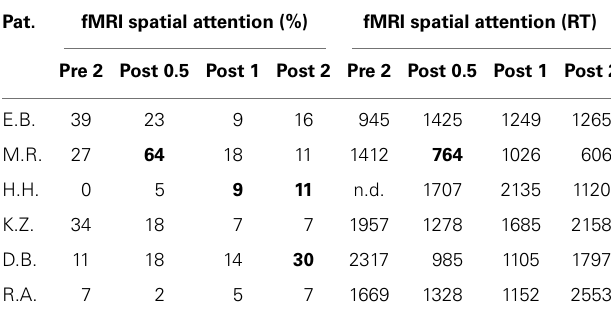
Table 6 | Behavioral results in the fMRI tasks. Pat.